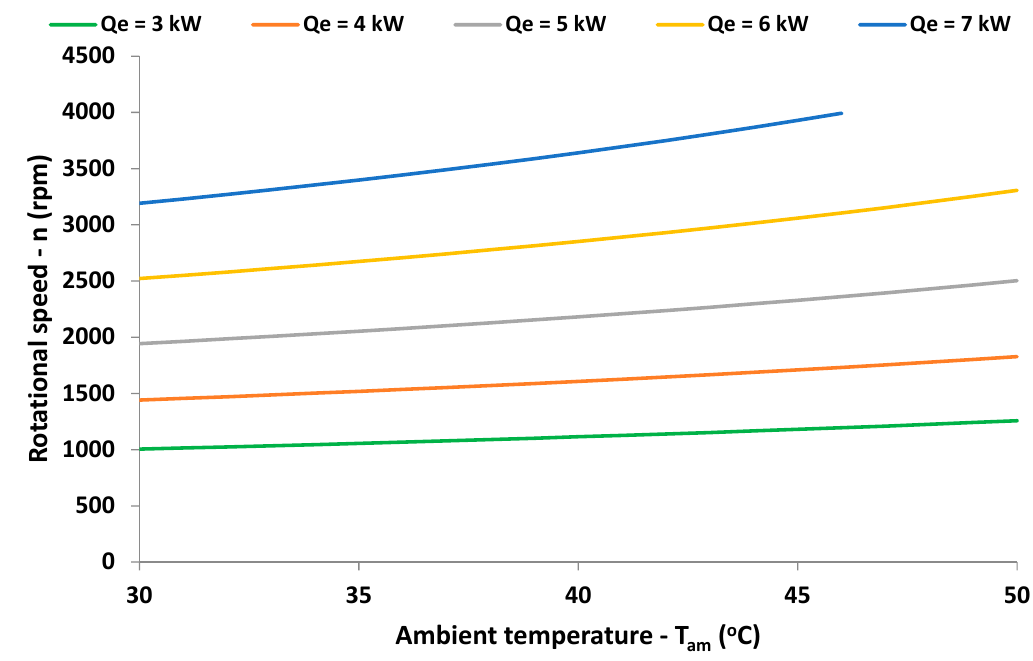
Figure 15. Rotational speed for different ambient temperatures and cooling capacities ( T ind = 25 °C and 1000 rpm < n < 4000 rpm).